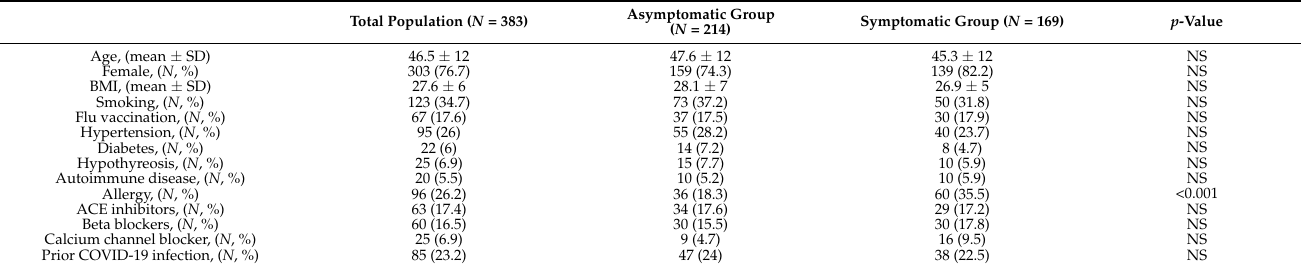
Table 1. Baseline characteristics of study participants based on post-vaccination adverse event status. Data are presented as means with standard deviation or median with interquartile range as appropriate. Proportions are expressed both as numbers and percentages. A p -value less than 0.05 was considered statistically significant. BMI, body mass index; ACE-inhibitors, Angiotensin-converting enzyme-inhibitors; COVID-19, Coronavirus disease; NS, non-significant. TotalPopulation( N =383) AsymptomaticGroup ( N =214) SymptomaticGroup( N